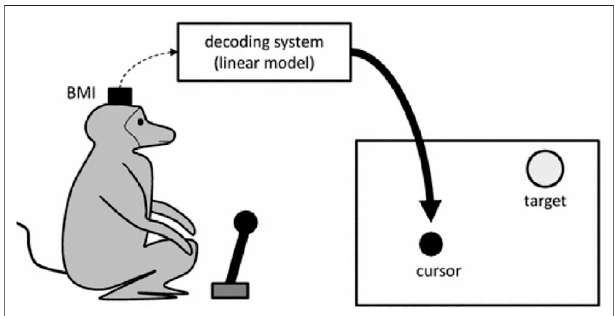
FIGURE 1 | Pictorial representation of one of the experiments described inCarmenaetal.(2003),wherethecursoris “ braincontrolled ” via